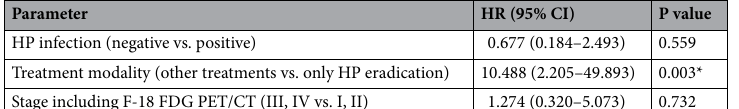
Parameter HR (95%